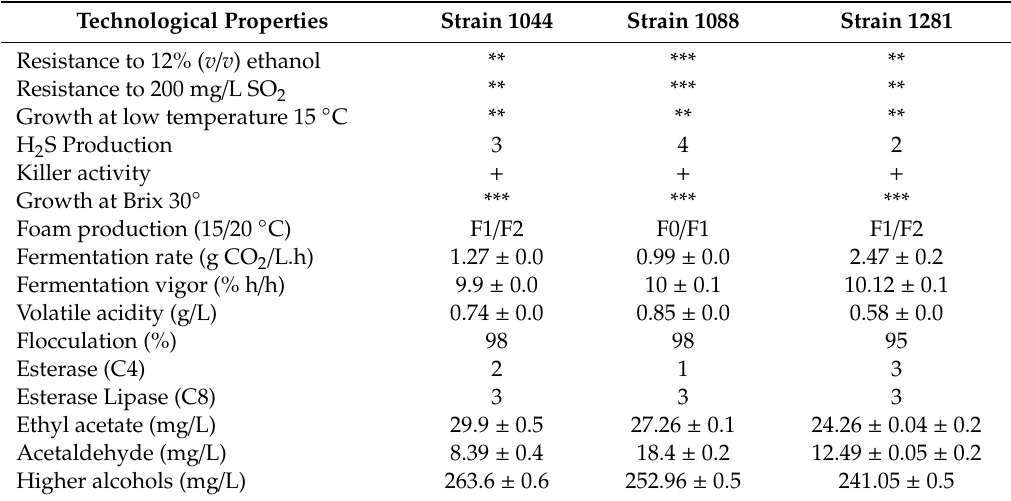
Table 1. Technological properties of autochthonous S. cerevisiae strains previously isolated from spontaneous fermentations of Narince